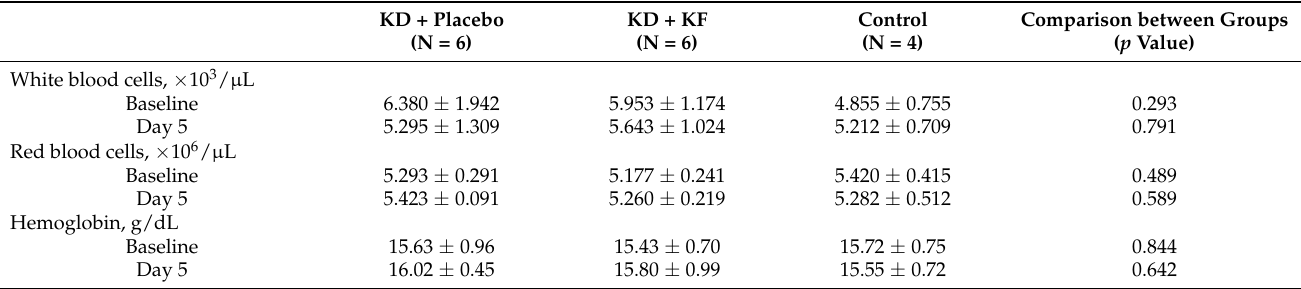
Table 5. Blood test